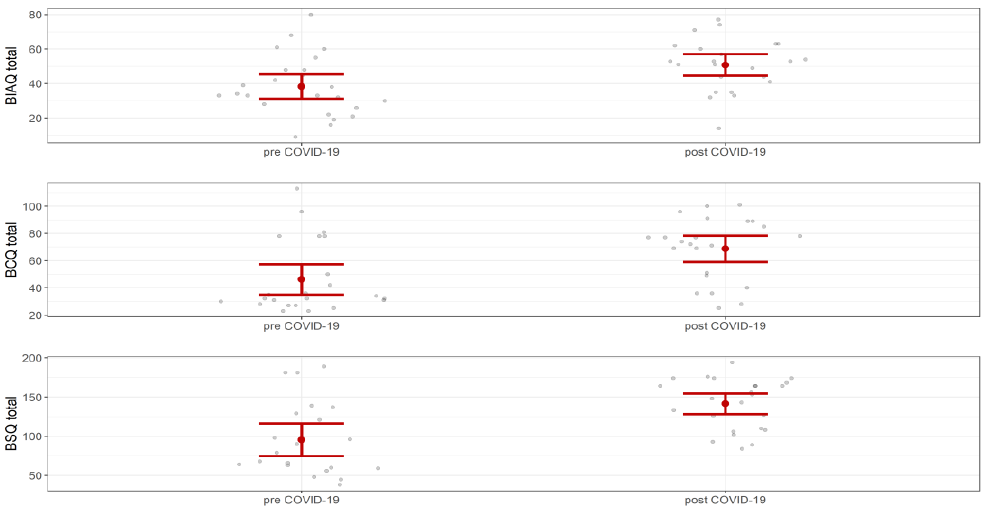
Figure 2. Body Image Avoidance Questionnaire (BIAQ), Body Checking Questionnaire (BCQ), Body Shape Questionnaire (BSQ) total scores in inpatients with extreme-AN.